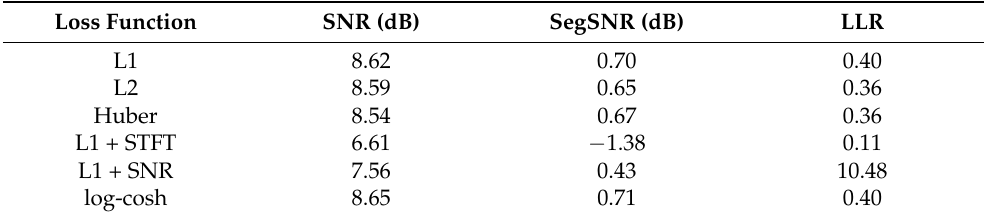
Table 2. Model’s performance with 8-layer SRU++ under different loss functions. The training epoch was 50 and the batch size was